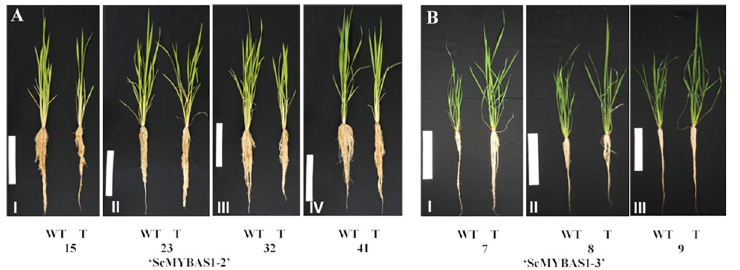
Fig 6. Phenotypes of T 1 transgenic rice overexpressing ScMYBAS1-2 and ScMYBAS1-3 . A: ScMYBAS1-2 transgenic lines after 45 days growth in greenhouse conditions, I—IV: 15, 23, 32 and 41. B: ScMYBAS1-3 transgenic lines after 30 days growth in greenhouse conditions, V—VII: 7, 8 and 9. Left: WT plants; Right: transgenic plants. White bar = 20 cm.